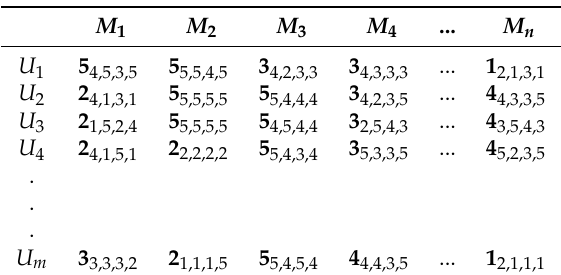
Table 1. Example of rating matrix in MCRSs